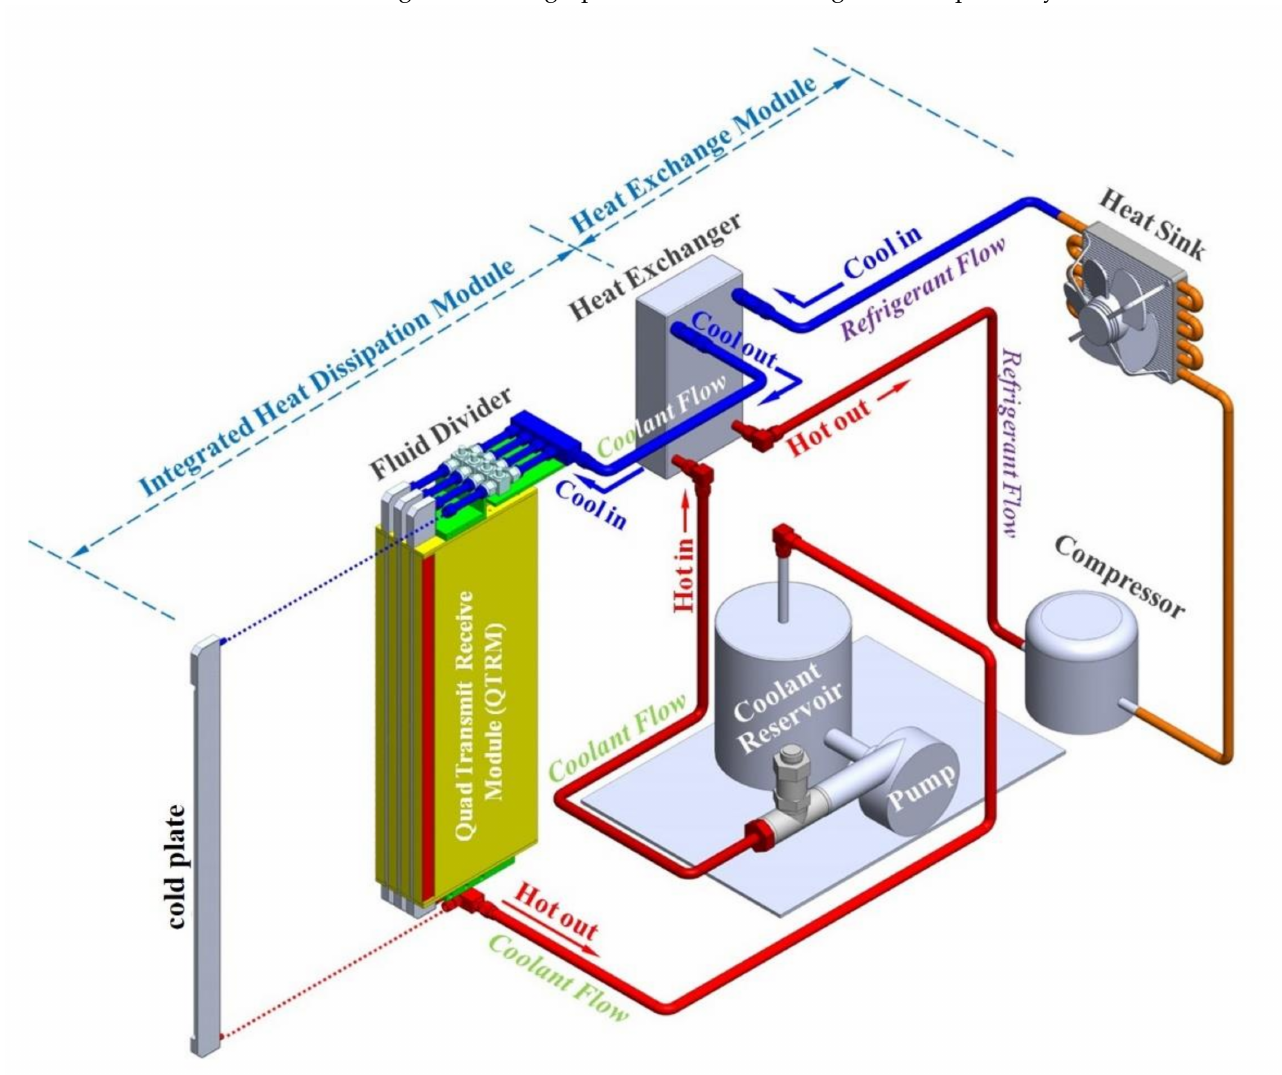
Figure 1. Fluid circulation heat dissipation